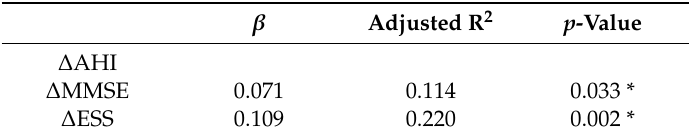
Table 5. Regression analysis concerning CPAP treatment e ff